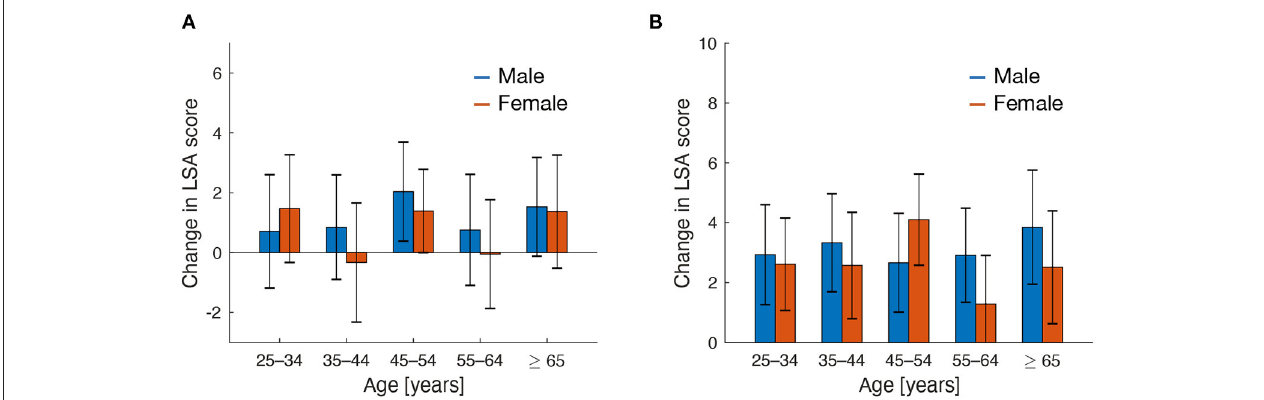
FIGURE 3 | Going-out activities in the future after the end of the COVID-19 pandemic relative to those in the baseline period. Going-out activities assessed with the LSA score were compared in terms of age and gender. (A,B) Show changes in overall going-out activities and those specific to leisure purposes, respectively. Error bars represent 95% confidence intervals.